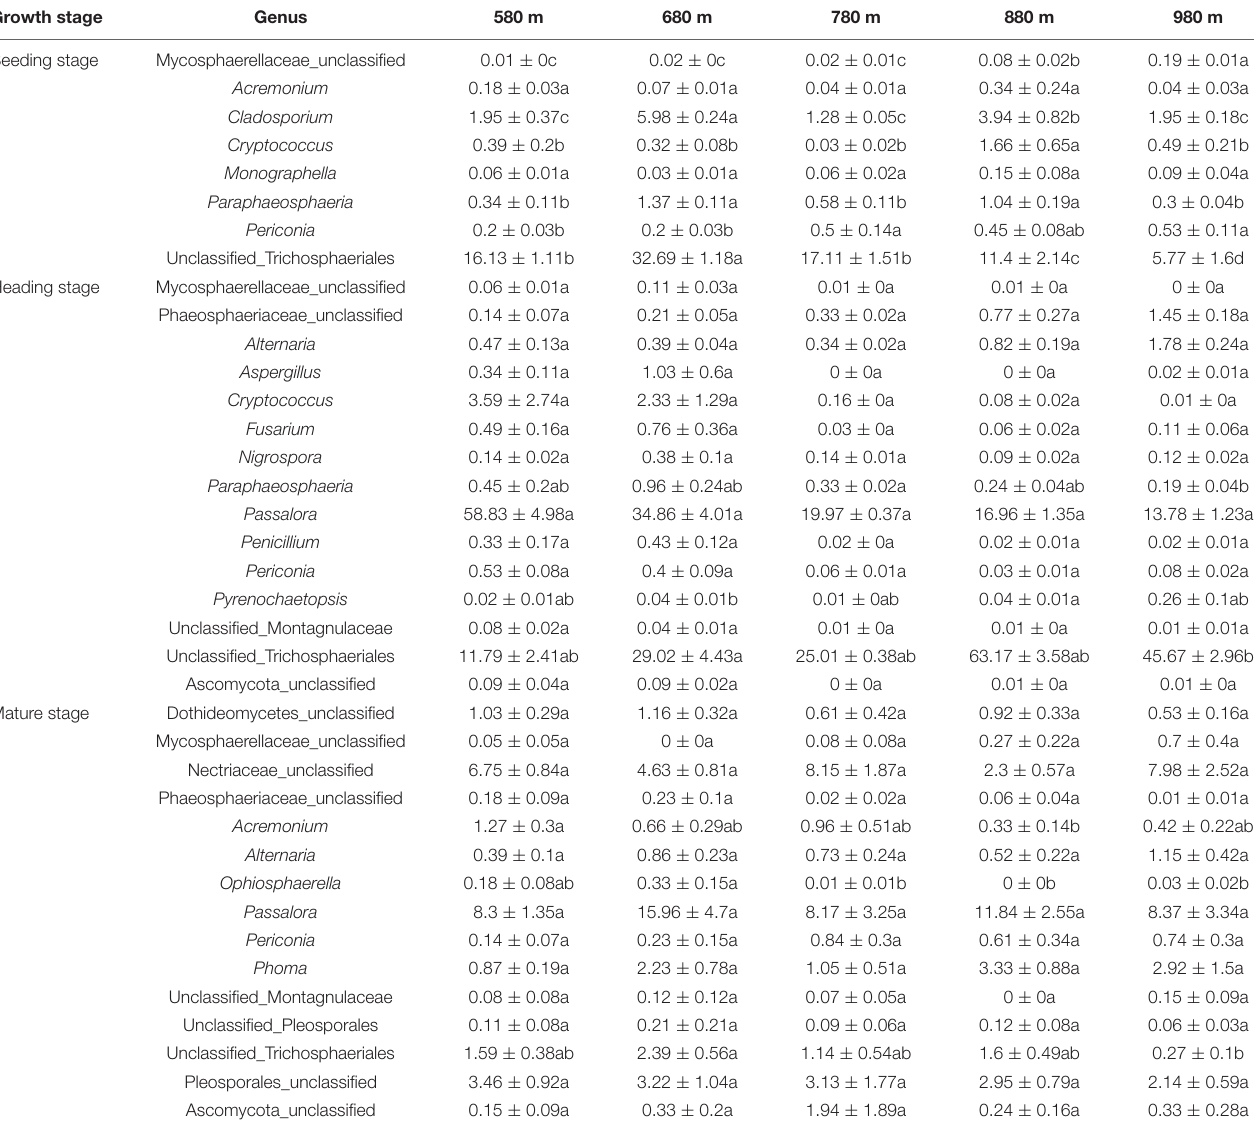
TABLE 3 | The relative abundance of genera was significantly correlated with elevation among the top 30 phyllosphere fungal genera. Growth